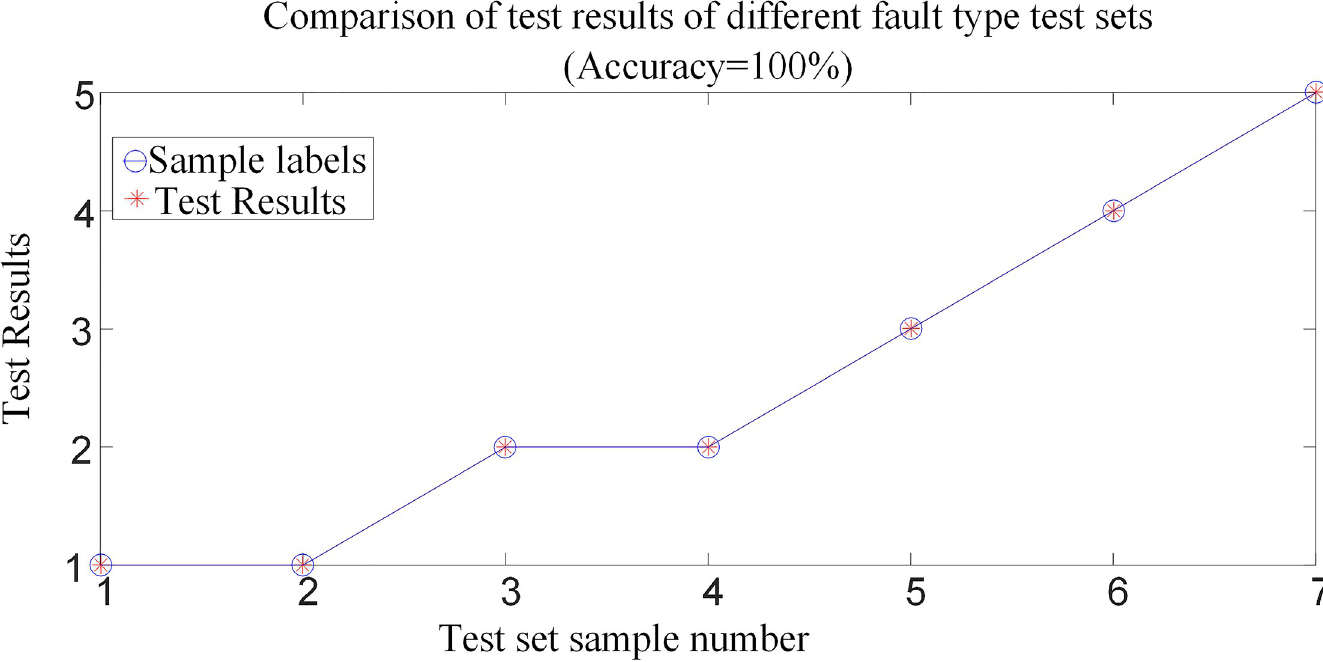
Fig 14. Comparison of test results when different types of faults